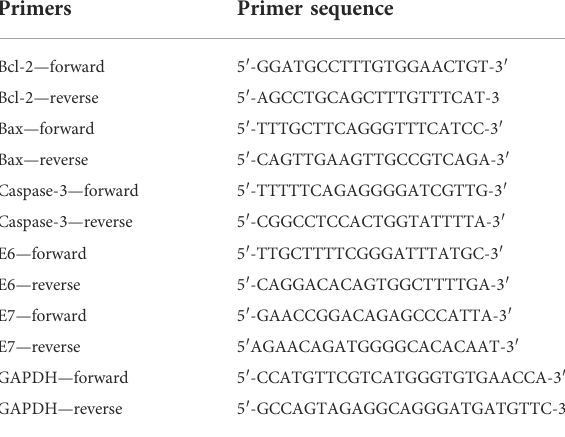
TABLE 1 Primer sequences used in RT-qPCR gene expression